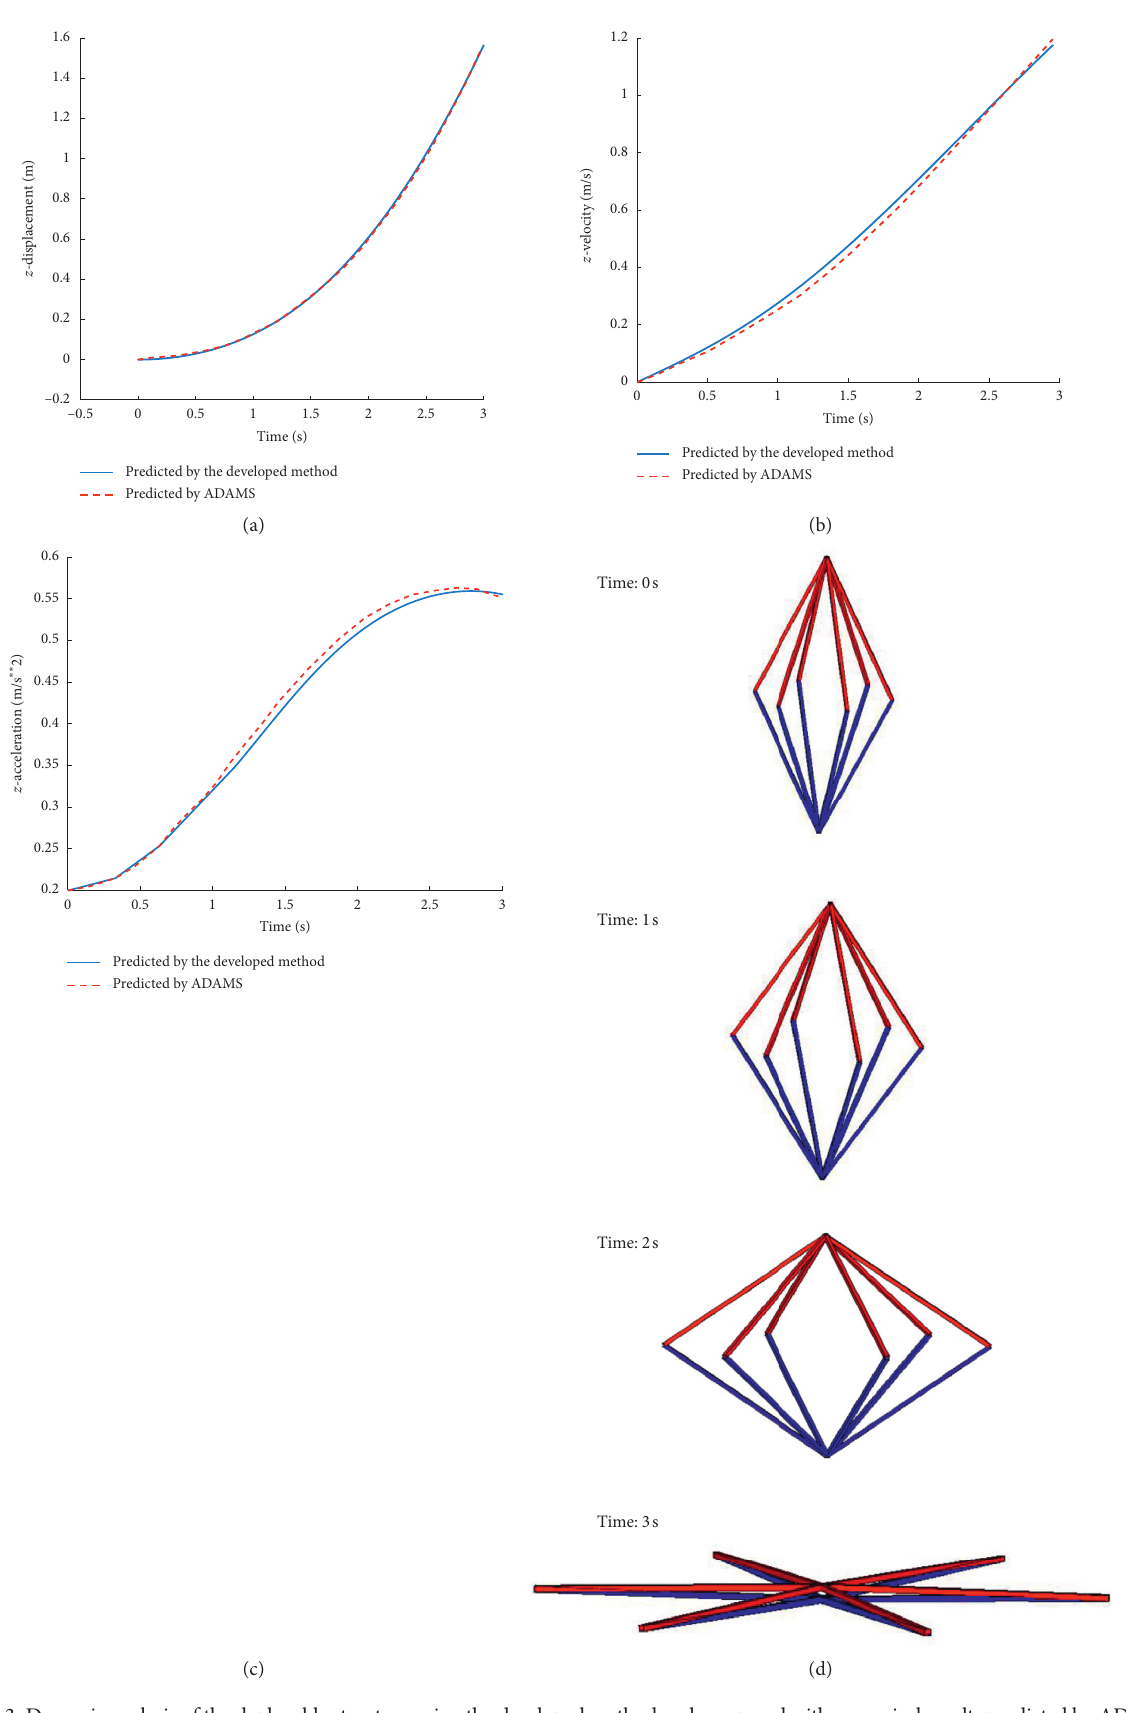
Figure 3: Dynamic analysis of the deployable structure using the developed method and compared with numerical results predicted by ADAMS. (a) z -displacement of node 8. (b) z -velocity of node 8. (c) z -acceleration of node 8. (d) Transformations of mode shapes during the motion